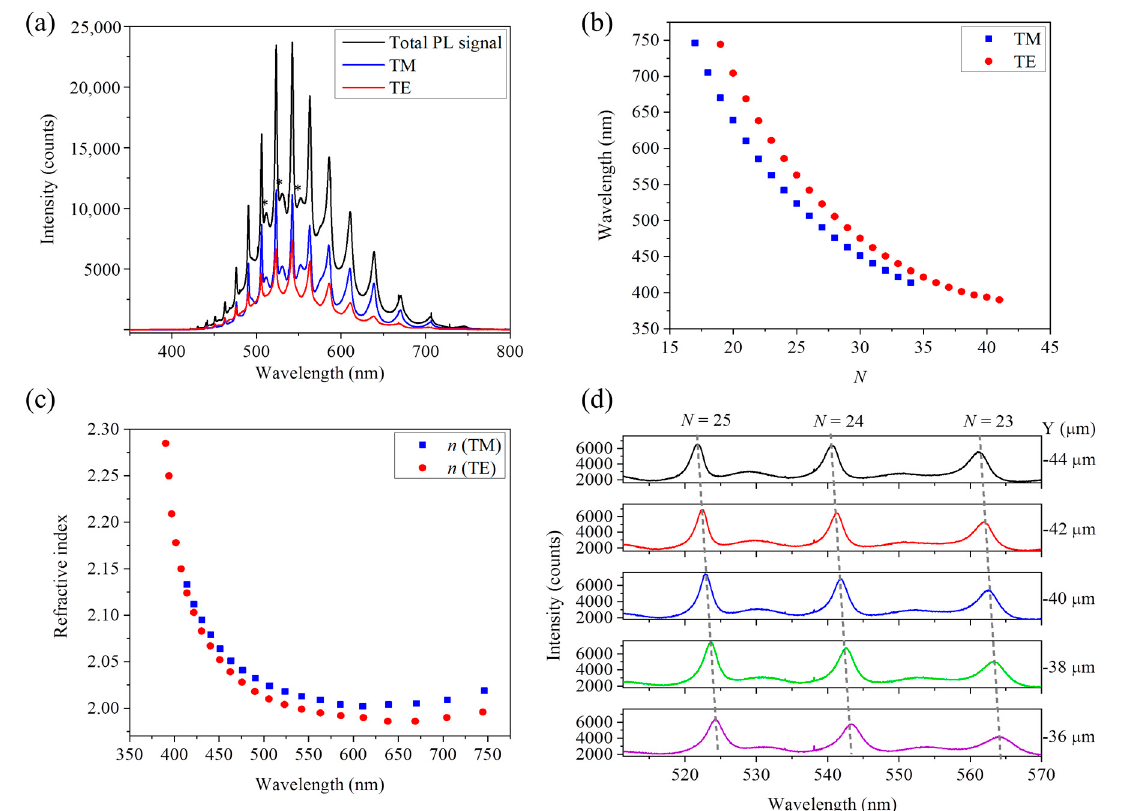
Figure 4. Analysis of the whispering gallery modes observed in region (i) of the structure in Figure 3a. The length side “a” of the cavity was 1.34 µ m at the selected point. ( a ) µ -PL spectra for all the polarization conditions. ( b ) Interference order N of the peaks observed in the spectra of part ( a ). ( c ) Refractive index estimated from the wavelength position of the resonant peaks. ( d ) Variation of the order N wavelength position as a function of the position along the structure, i.e., as a function of the size of the